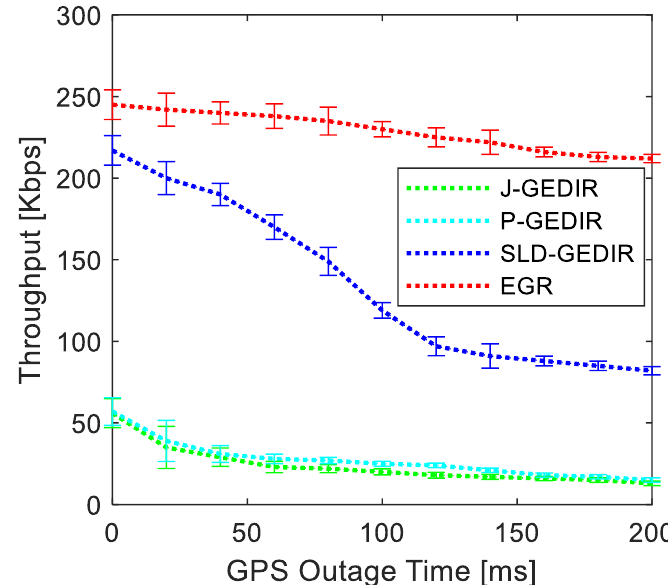
Figure 9. Effect of GPS outage on throughput.